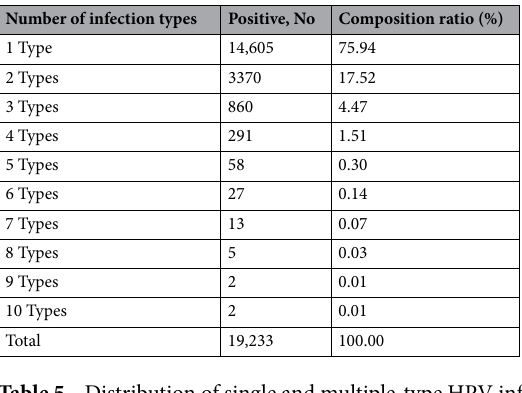
Table 5. Distribution of single and multiple-type HPV infections.